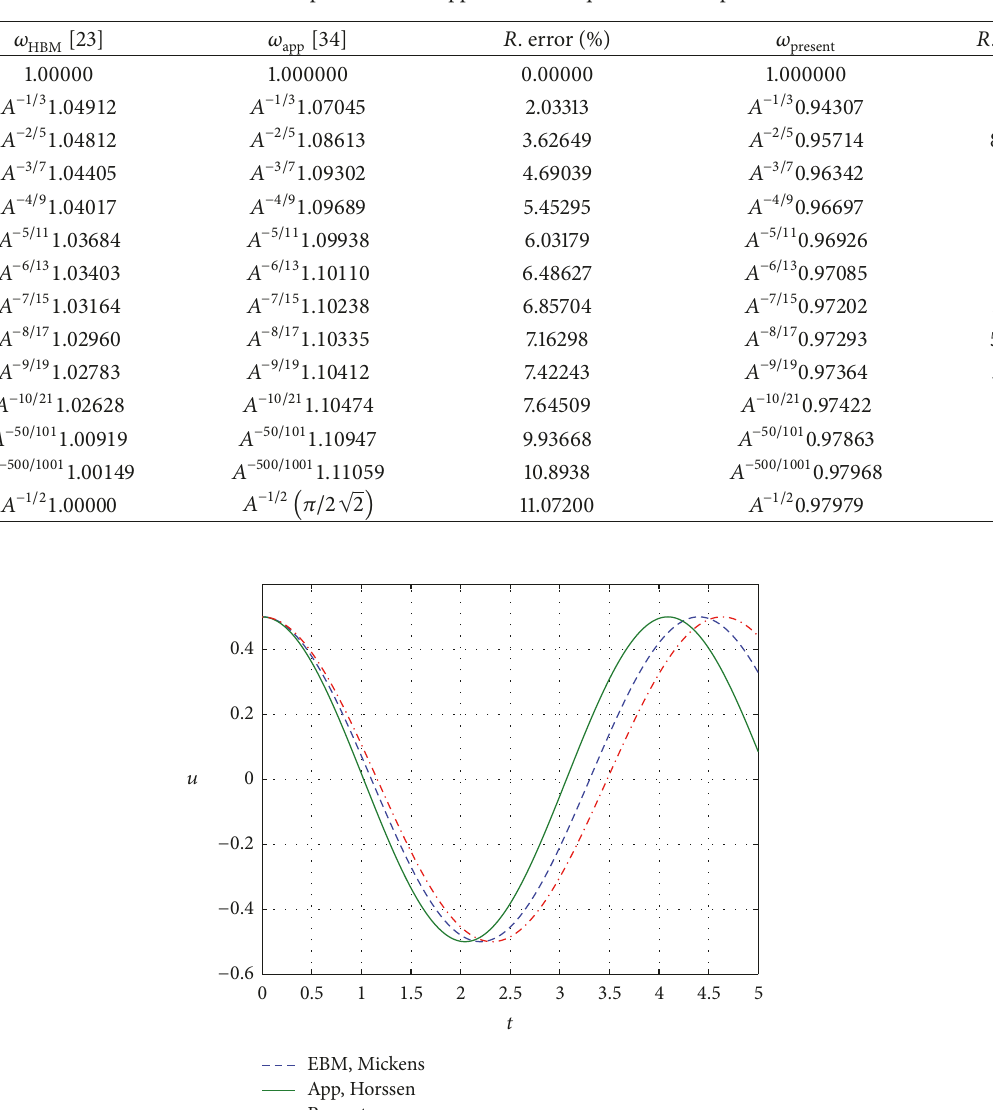
Table 5: Comparison of the approximate frequencies, Example 5.